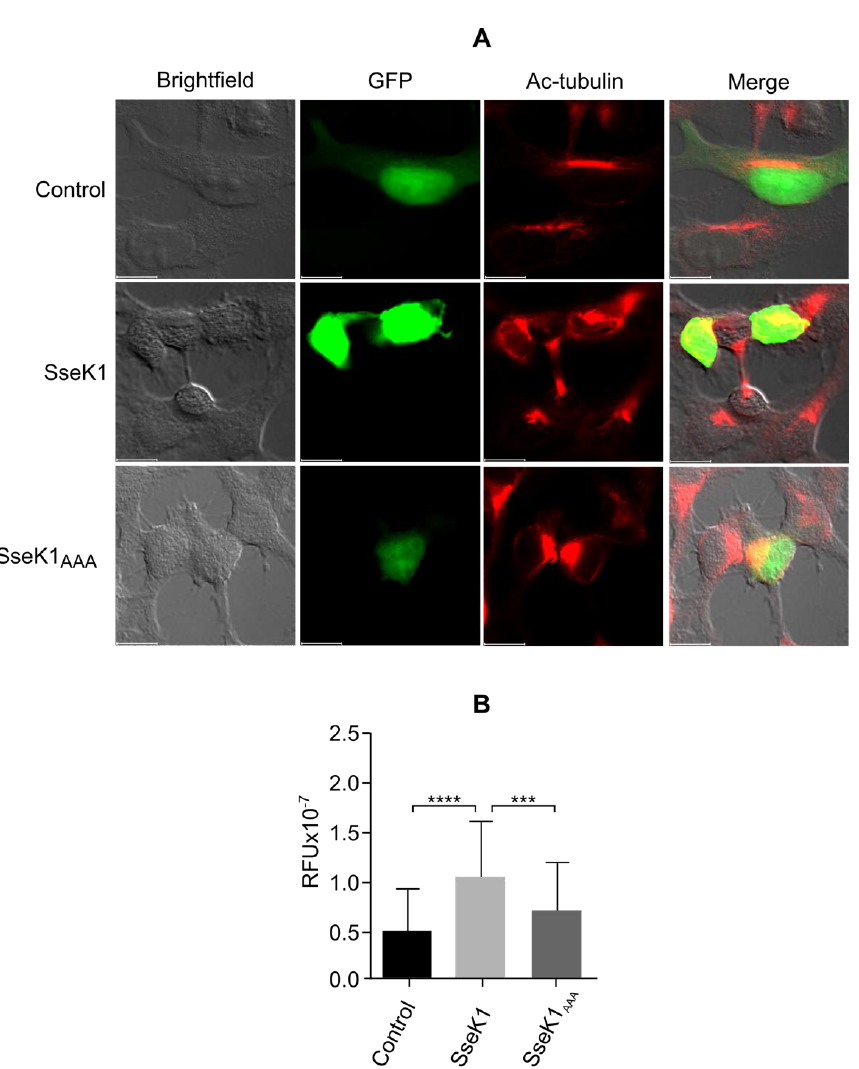
Figure 7. SseK1 increases the acetylation level of tubulin in HEK293T cells. ( A ) Representative fluorescence microscopy images showing GFP (Control) or GFP fusion proteins (GFP-SseK1 or GFP-SseK1 AAA ,) in green, and acetyl- α -tubulin in red. HEK293T cells were transfected with derivatives of plasmid pEGFPC1, and 48 h after transfection cells were fixed with 4% paraformaldehyde and stained with anti-acetyl- α -tubulin rabbit monoclonal antibody and Alexa Fluor Plus 594-conjugated anti-rabbit secondary antibody. ( B ) Quantification of acetyl- α -tubulin from immunofluorescence images of cells transfected with GFP (Control) or GFP fusion proteins (GFP-SseK1, GFP-SseK1 AAA ). The mean and standard deviation from 100 cells are represented for each condition. RFU, relative fluorescence units. ***, P < 0.001; ****, P < 0.0001, for the indicated comparisons using a Kolmogorov–Smirnov test.